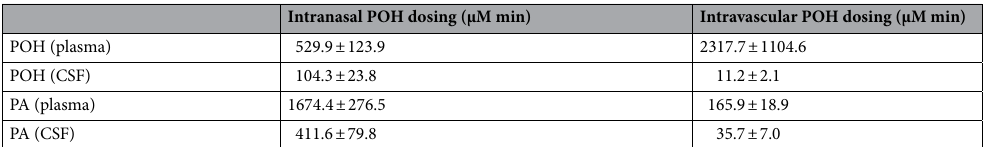
Table 1. Total analyte exposure or AUC 70 . Total drug exposure values for POH and PA in the rat plasma and CSF over 70 min of experimental duration. Values are depicted as mean ± standard error of mean (SEM). AUC 70 area under the concentration–time curve over the experimental timeframe (70 min).